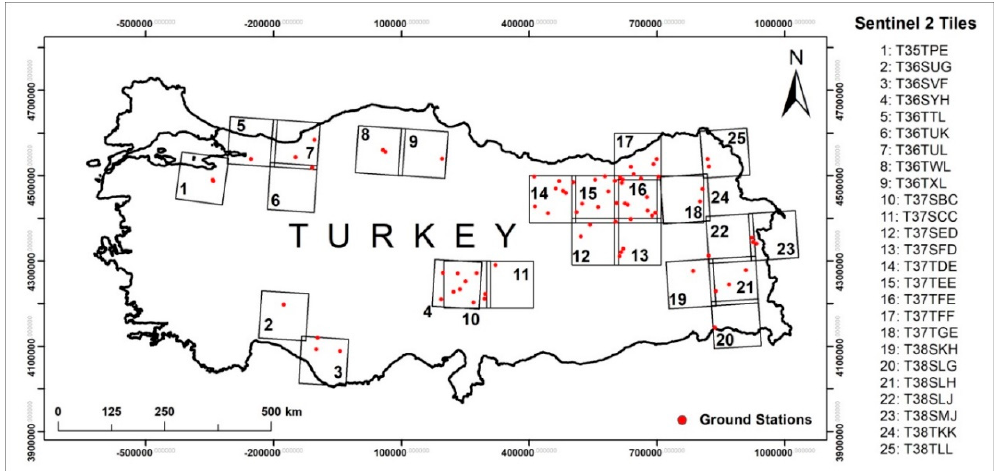
Figure 8. Locations of ground-based monitoring stations in S-2 tiles.